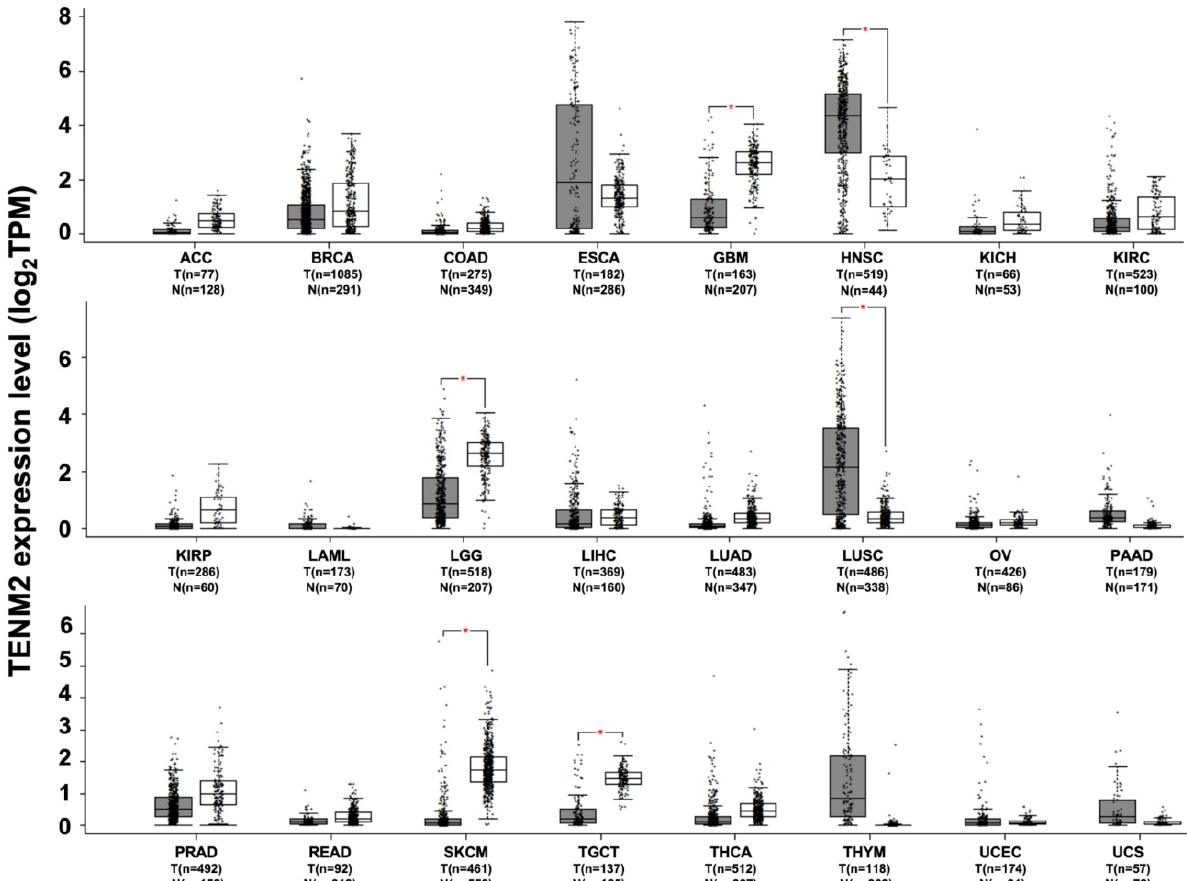
Figure 3. TENM2 expression in different datasets of tumors and normal samples. TENM2 expression level, shown as log2 of transcript per million mapped reads value, was analyzed from RNA sequencing data of tumors and normal samples from the TCGA and the GTEx projects, using a web standard processing pipeline [43]. Tumor (T) and normal samples (N) are represented in grey and white box plots, respectively, each dot representing a sample ( n = number of samples within the dataset). Statistical differential analysis was performed using the GEPIA default recommended parameters, one-way ANOVA, |Log2FC| ≥ 1 and p ≤ 0.01. Datasets description: ACC; Adrenocortical carcinoma. BRCA; Breast invasive carcinoma. COAD; Colon adenocarcinoma. ESCA; Esophageal carcinoma. GBM; Glioblastoma multiforme. HNSC; Head and neck squamous cell carcinoma. KICH; Kidney chromophobe. KIRC; Kidney renal clear cell carcinoma. KIRP; Kidney renal papillary cell carcinoma. LAML; Acute myeloid leukemia. LGG; Brain lower grade glioma. LIHC; Liver hepatocellular carcinoma. LUAD; Lung adenocarcinoma. LUSC; Lung squamous cell carcinoma. OV; Ovarian serous cystadenocarcinoma. PAAD; Pancreatic adenocarcinoma. PRAD; Prostate adenocarcinoma. READ; Rectum adenocarcinoma. SKCM; Skin cutaneous melanoma. TGCT; Testicular germ cell tumors. THCA; Thyroid carcinoma. THYM; Thymoma. UCEC; Uterine corpus endometrial carcinoma. UCS; Uterine carcinosarcoma.